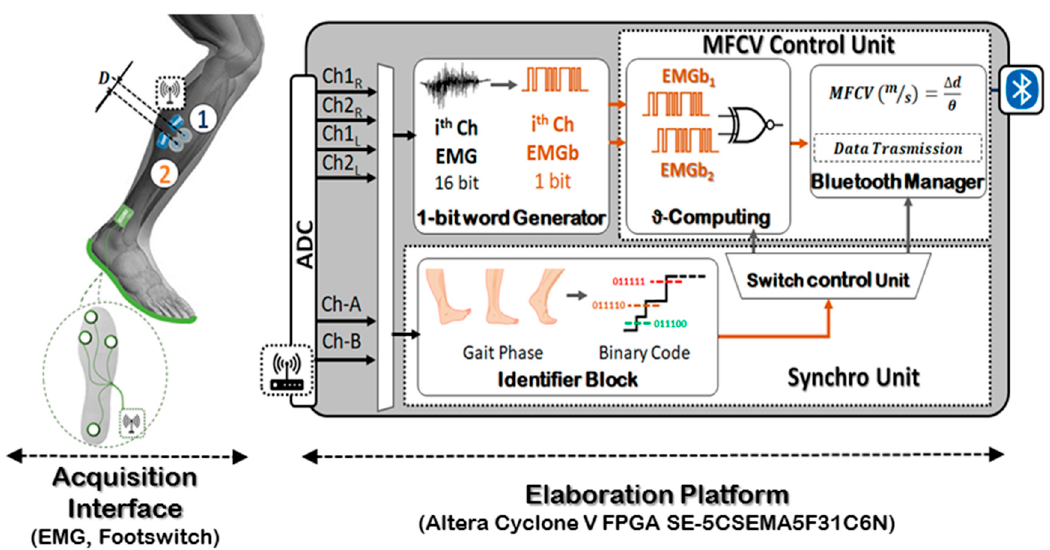
Figure 1. System architecture.